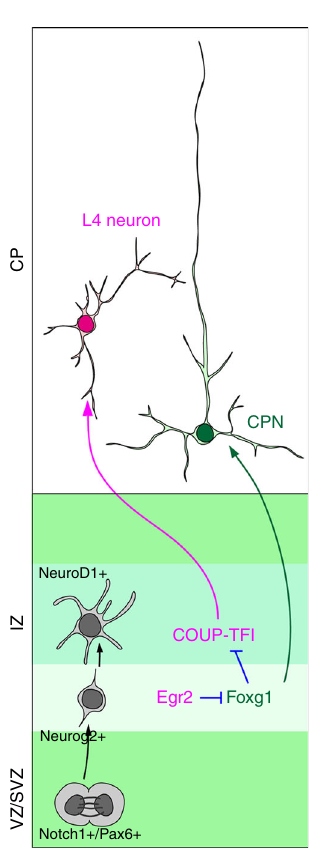
Fig. 10 Proposed model for short- and long-range projection neuron selection. After the cell cycle exit, Egr2 is activated in early postmitotic neurons and suppresses Foxg1 expression in the lower intermediate